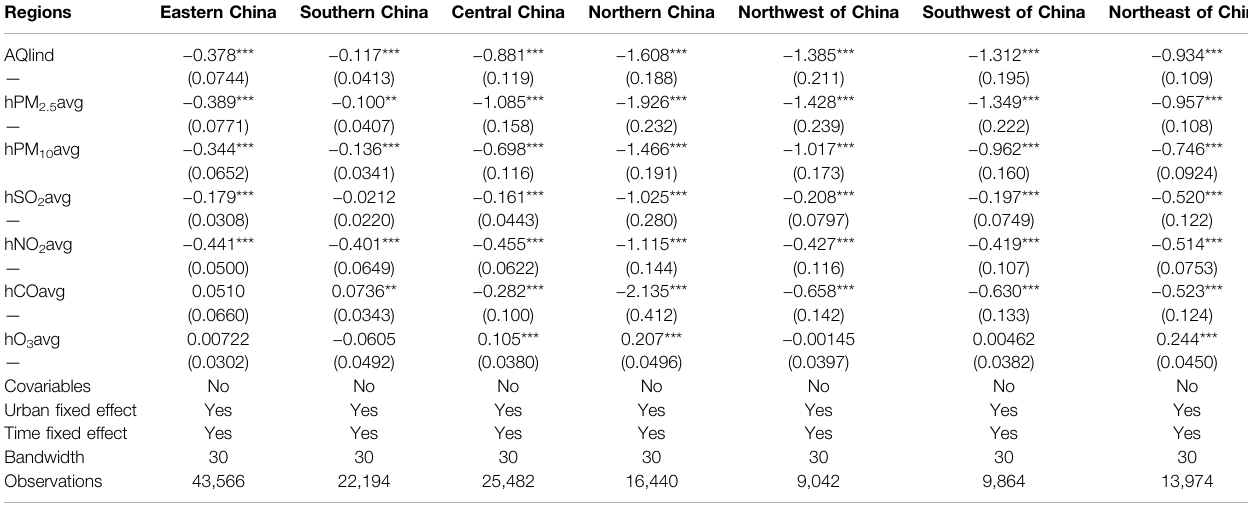
TABLE 9 | Sharp RD design results for the seven regions of China. Regions Eastern China Southern China Central China Northern China Northwest of China Southwest of China Northeast of China